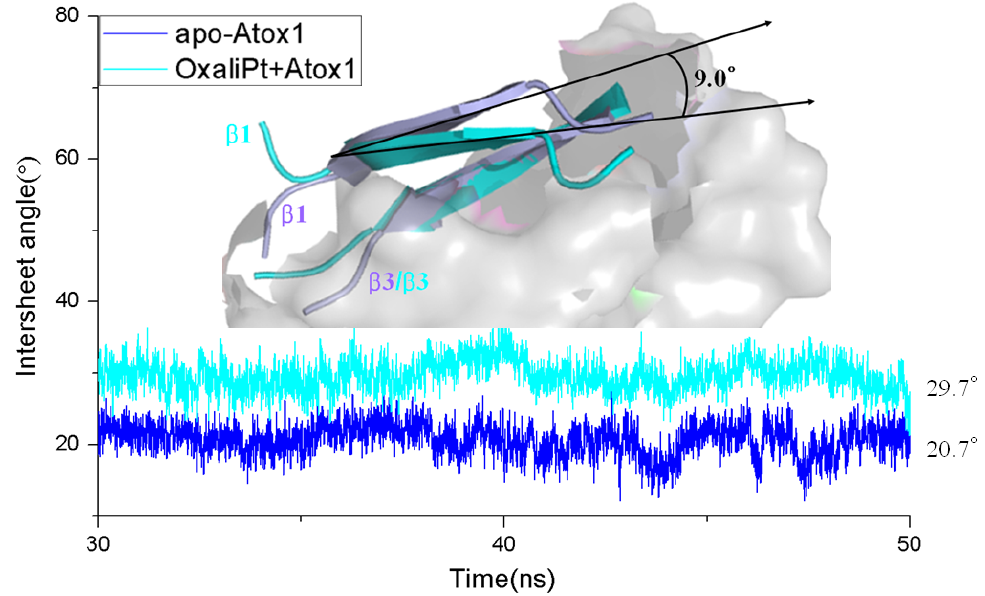
Figure 5. The time-dependence of the intersheet angles between the β 1 and β 3 strands of the Atox1 protein for the apo-Atox1 ( light blue ) and OxliPt + Atox1 ( cyan ) models. The inset is the visual superposition for the average structures of the β 1 and β 3 strands for the two